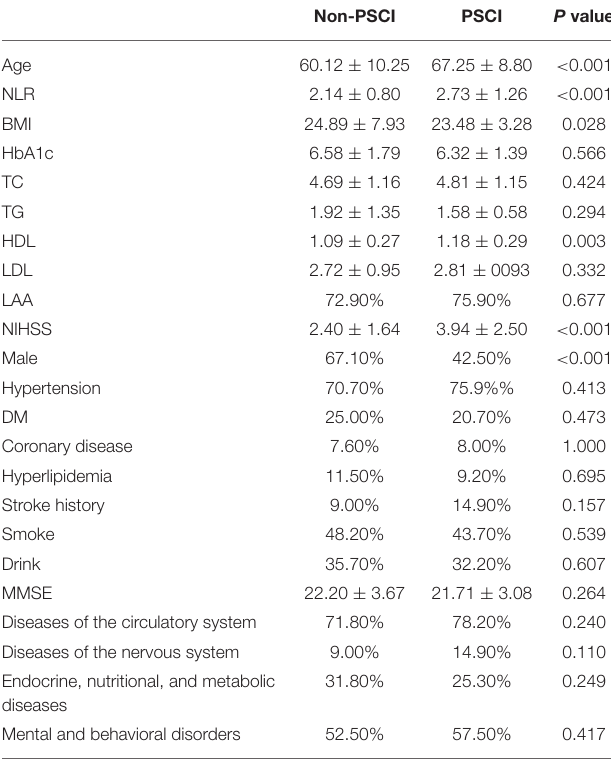
TABLE 1 | Clinical and demographic characteristics of the samples under